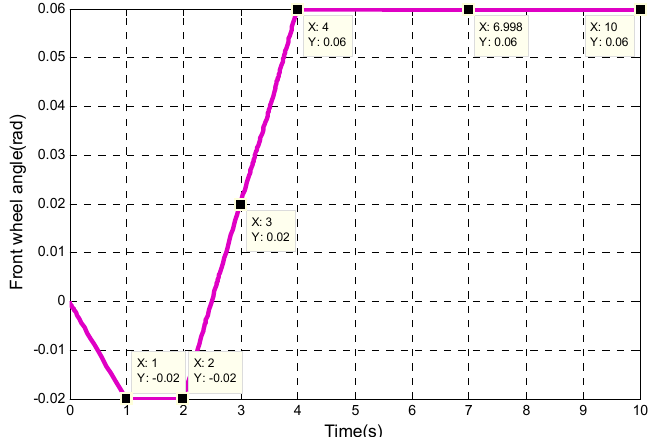
Figure 22. The front wheel angle under the fishhook maneuver.